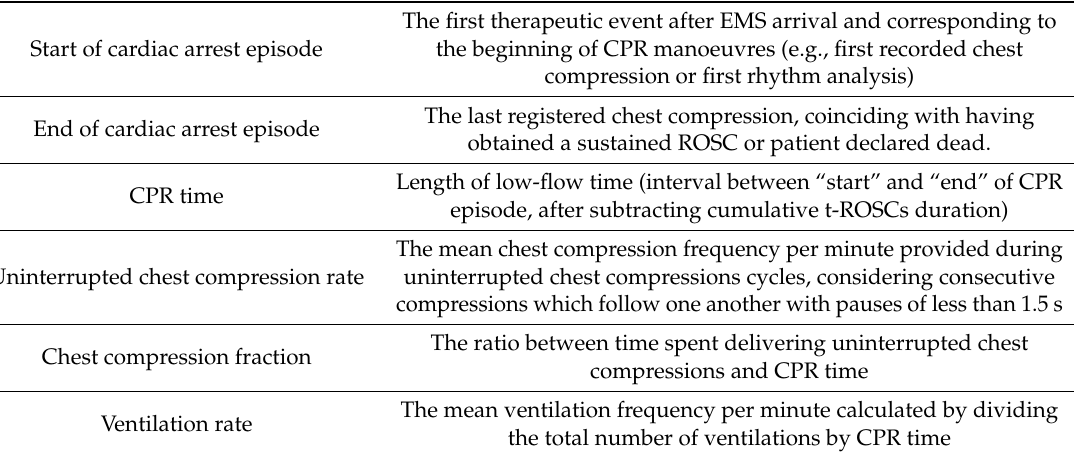
Table 1. Definition of study variables related to CodeStat